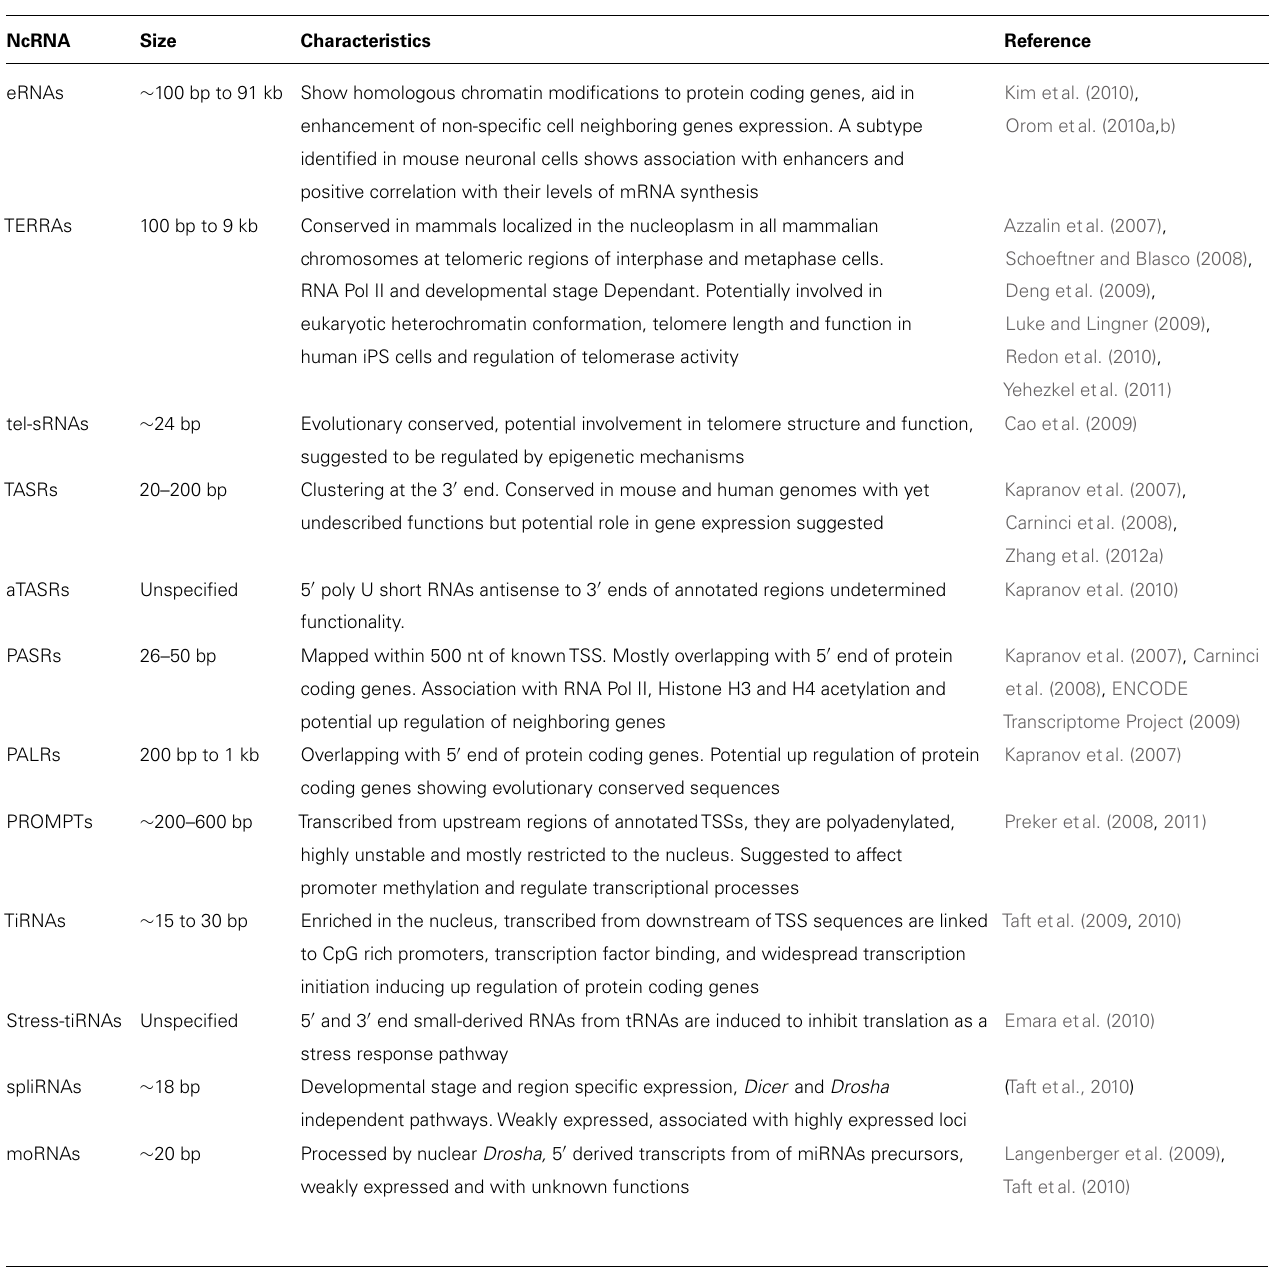
stress response pathway Developmental stage and region specific expression, Dicer and Drosha independent pathways. Weakly expressed, associated with highly expressed loci Processed by nuclear Drosha, 5 (cid:3) derived transcripts from of miRNAs precursors, weakly expressed and with unknown